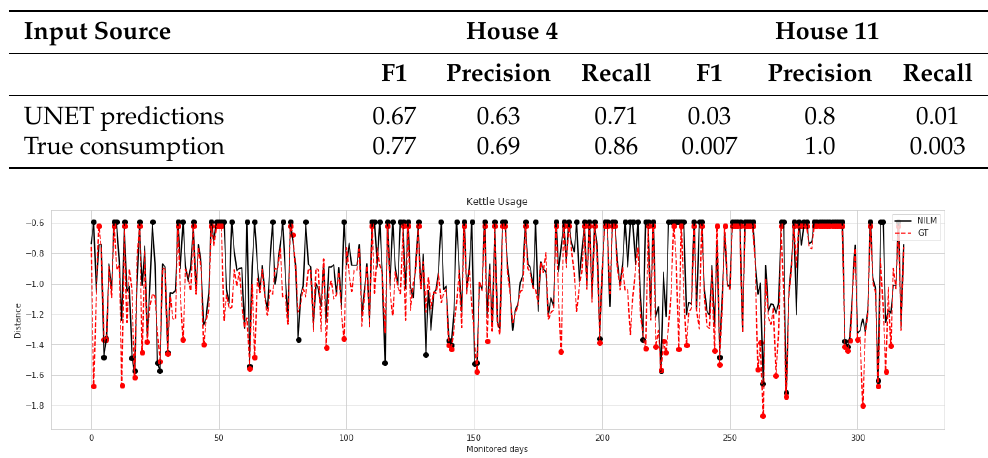
Table 8. The results of the evaluation of the activity monitoring module.